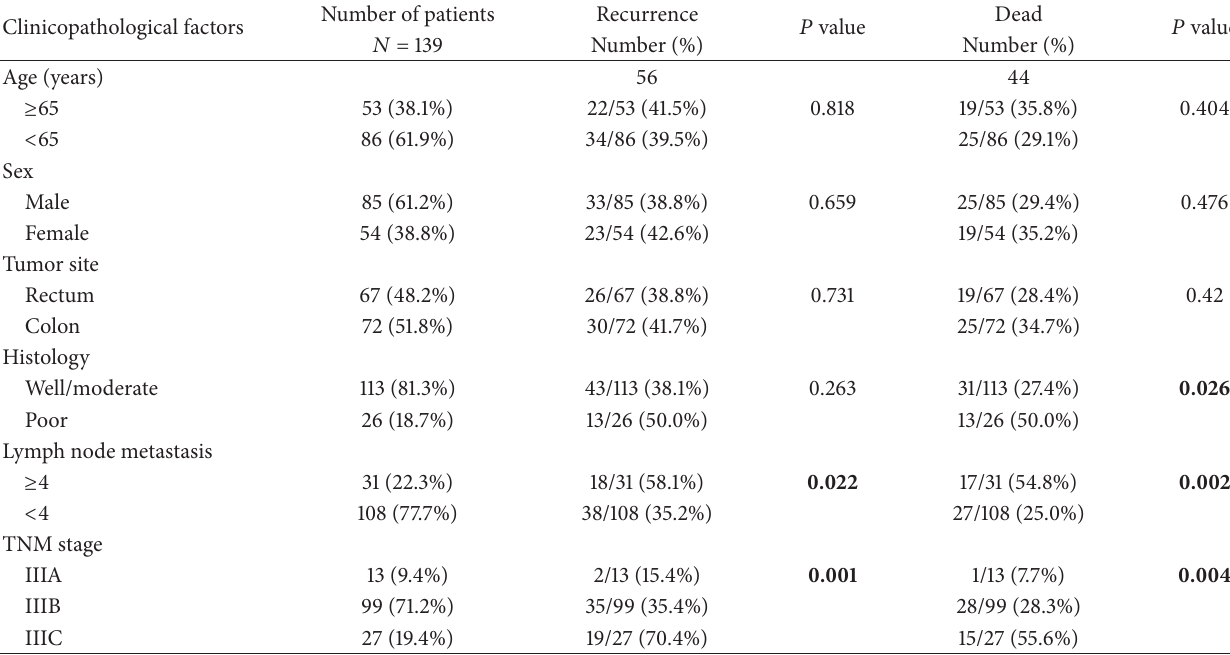
Table 1: Selected demographic and clinical characteristics of patients with